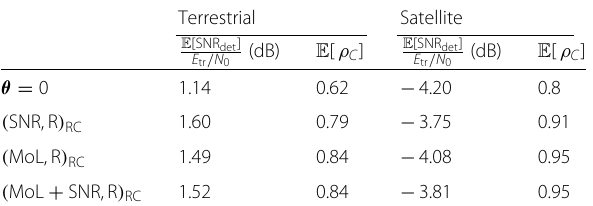
Table 4 E [SNR det ] (dB) and E [ ρ C ] when optimizing rotation E tr / N 0 angles θ for 2-PAM